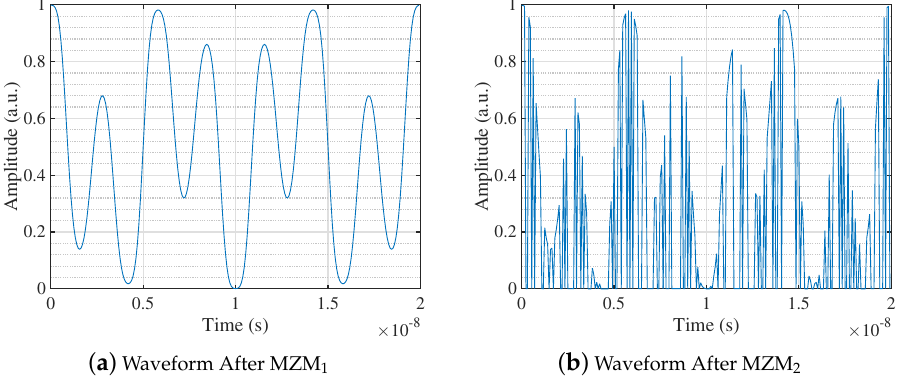
Figure 6. Waveforms of modulated signals. ( a ) One period of original signal. ( b ) One period of mixed